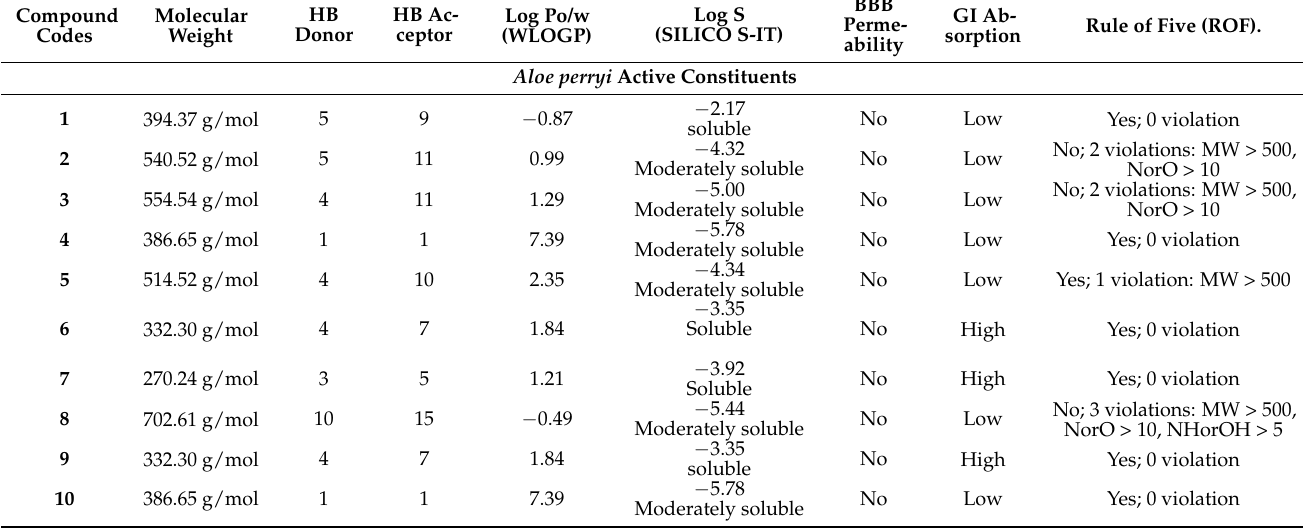
Table 4. The pharmacokinetic ADME properties of the active constituents of Aloe perryi extract. Compound Molecular Codes